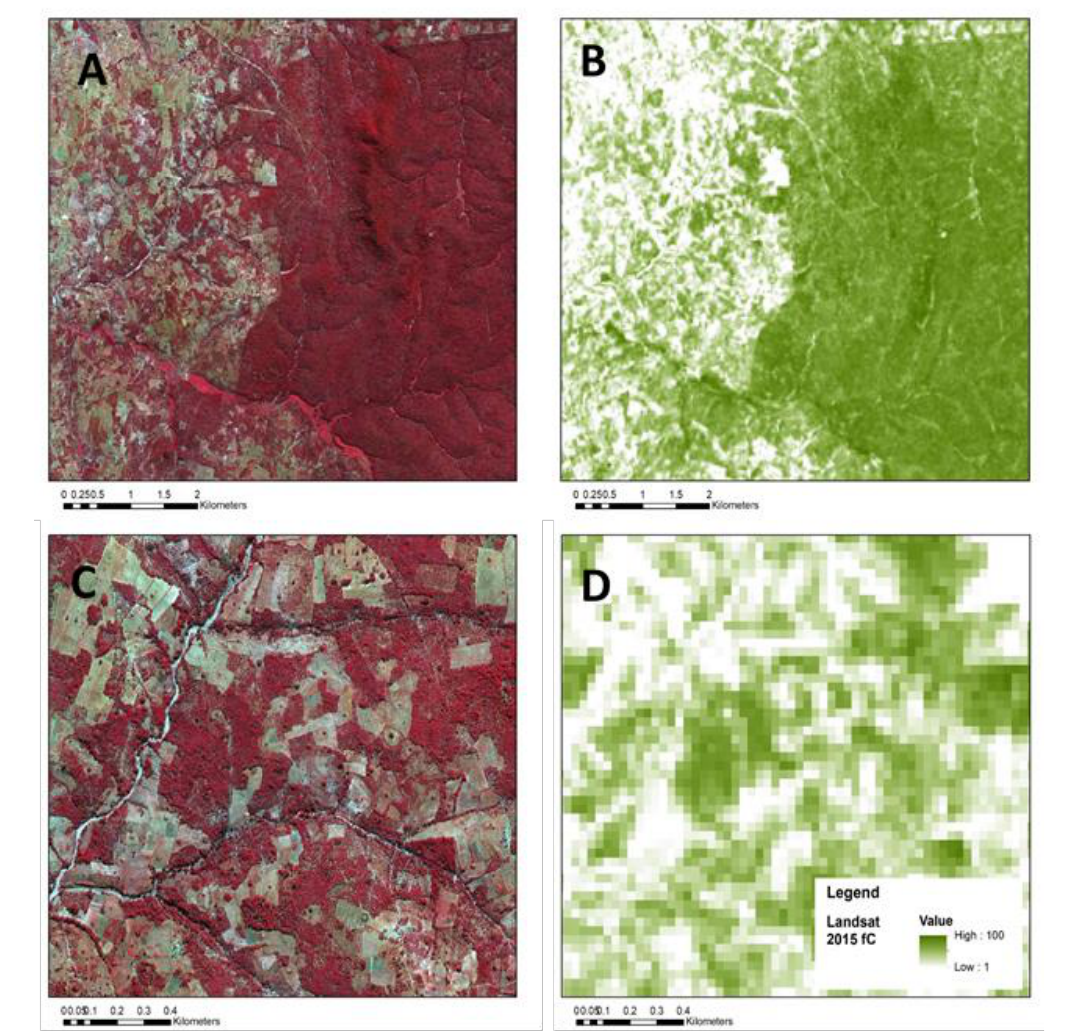
Figure 8. Examples of the f C product compared with very high-resolution (VHR) satellite data at 0.5 m resolution. ( A ) VHR, wide area perspective, ( B ) f C product, wide area perspective, ( C ) VHR, local area perspective, ( D ) f C product, local area perspective.